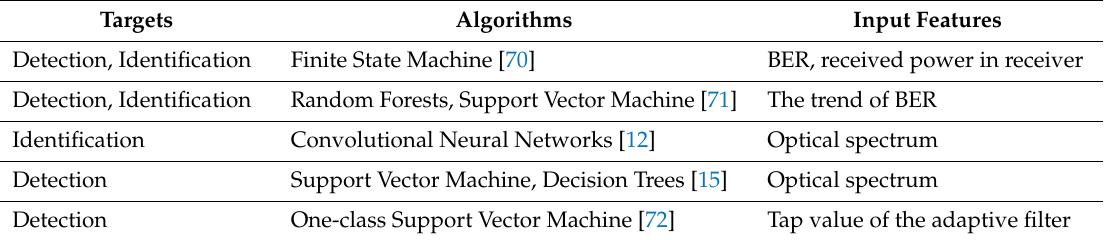
Table 4. Summary of the AI-based failure management techniques discussed in Section